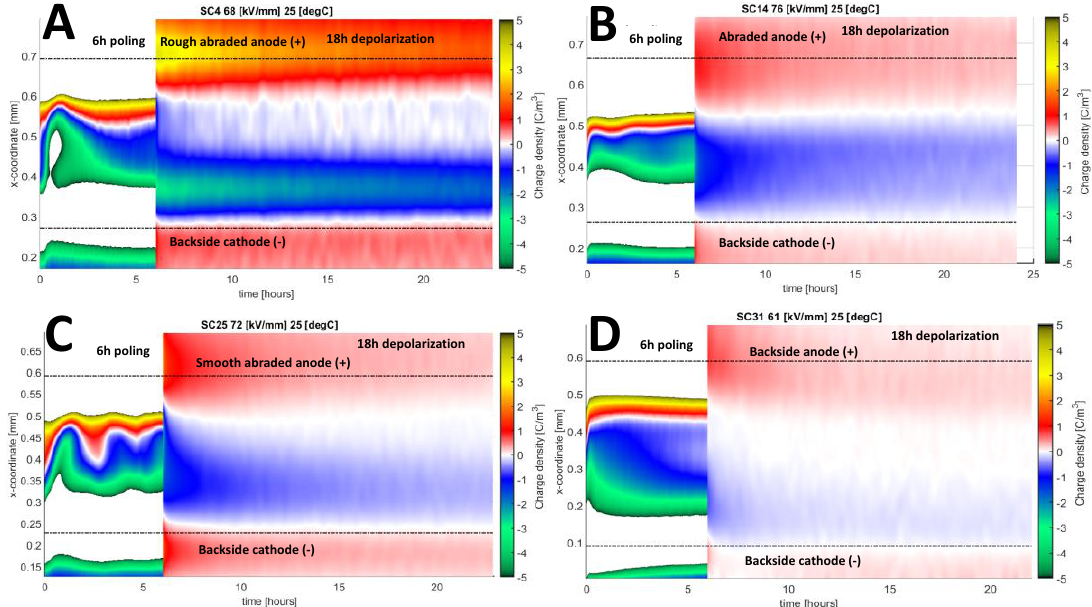
Figure 9. PEA measurements at high electric fields (61–76 kV/mm), at 25 °C and using +30 kV poling voltage, showing space charge packet-like behavior and fast initial depolarization. With a rough abraded sample ( A , top left), an abraded sample ( B , top right), a smooth abraded sample ( C , bottom left) and a backside sample ( D , bottom right). Data larger than ±5 C/m 3 has been colored white in the colormap.